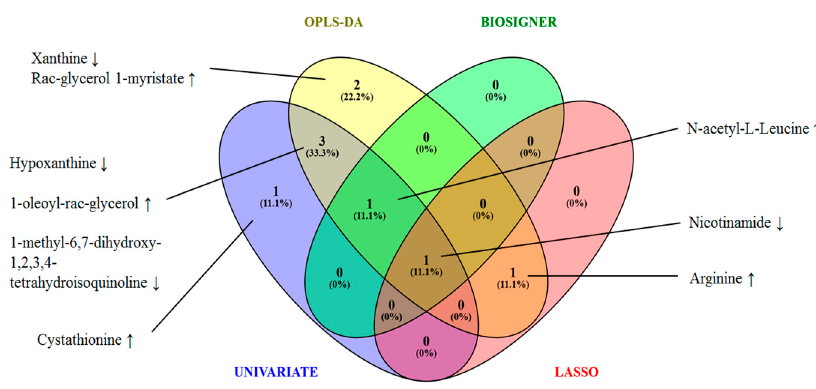
Figure 5. Venn diagram illustrating the global POAG signature.